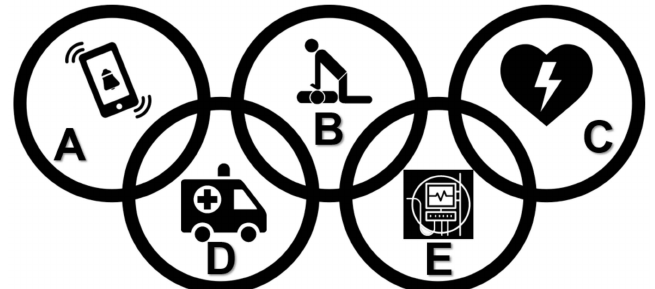
Figure 1. Out-of-hospital “Chain of Survival” of Sport (adapted from AHA [86]). ( A ) Recognition and activation of the emergency medical system, which varies according to country, city and locality; ( B ) immediate high-quality cardiopulmonary resuscitation, which includes administration / training / education in BLS; ( C ) rapid defibrillation—fast access to the automated external defibrillator; ( D ) access to advanced medical emergency services, which includes on-site care for sudden CA and transport to the in-hospital environment. ( E ) Advanced life support and post-cardiopulmonary resuscitation care—all of these actions occur in the hospital setting.